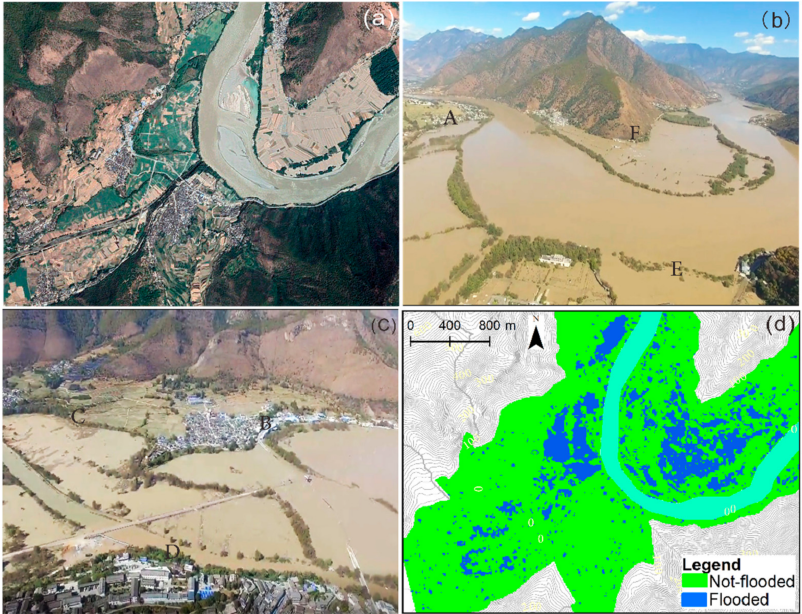
Figure 11. The mapping results accuracy evaluation. ( a ) Google Image; ( b , c ) Flood transit scene photos. Filming time: 12:00 a.m. of 15 November 2018. ( d ) the classification results of the region using CDAT algorithm.